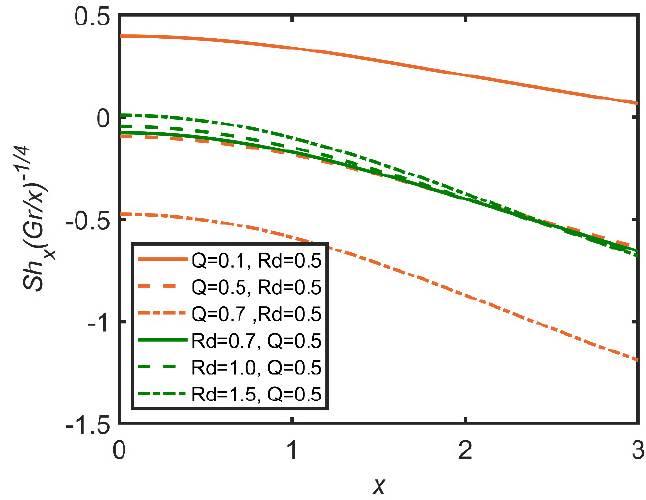
Figure 17. Comparison for Sherwood number against x.